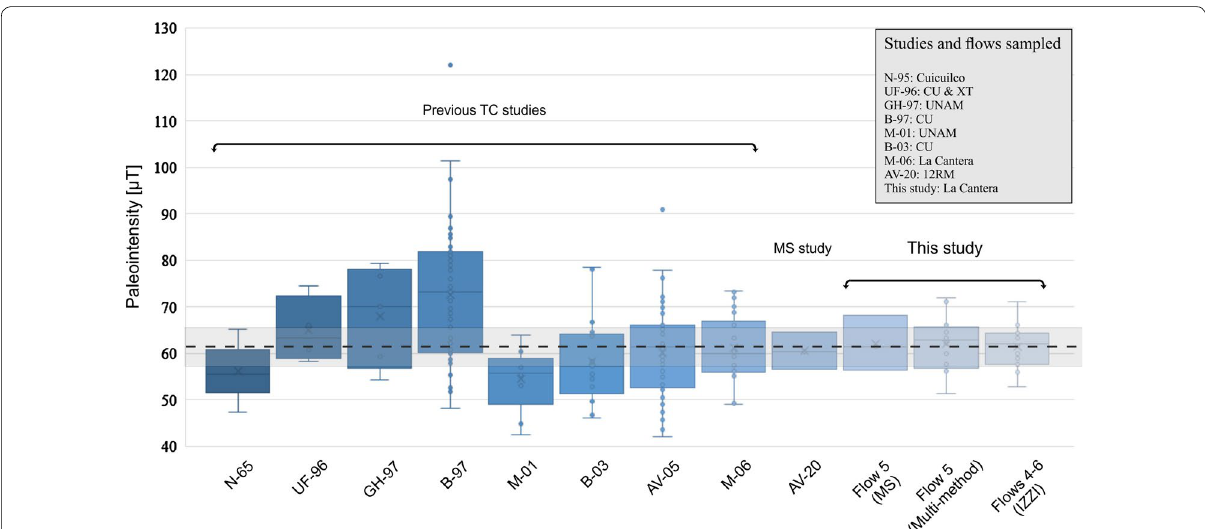
Fig. 7 Box‑and‑whisker plots showing the available lava PI data for Xitle, together with those obtained in this investigation. N‑65: Nagata et al. (1965a); UF‑96: Urrutia‑Fucugauchi (1996); GH‑97: Gonzalez et al. (1997); B‑97: Böhnel et al. (1997); M‑01: Morales et al. (2001); B‑03: Böhnel et al. (2003); M‑06: Morales et al. (2006); AV‑20: Alva‑Valdivia et al. (2020); Flow 5 (MS): mean PI result for Flow 5 obtained with the MS method; Flow 5 (multi‑method): mean PI result for Flow 5 obtained with the TC, IZZI CRcorr and MS methods; flows 4–6 (IZZI): mean PI result from flows 4–6 obtained with the IZZI CRcorr method. The dotted line and shaded area correspond to the Xitle’s mean IZZI CRcorr paleointensity value obtained in this study, and its associated standard